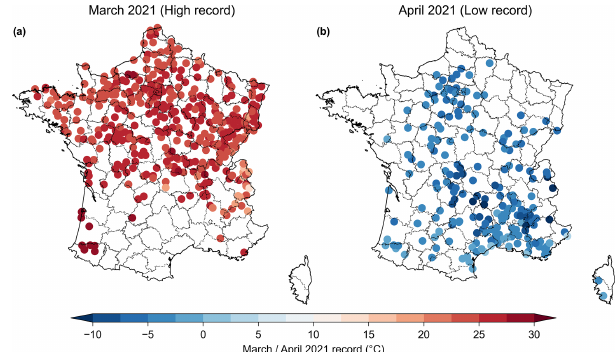
Figure 1. Stations with March (a) high records broken (pink ther- mometer) and April (b) low records broken (since at least 20 years) (blue thermometers) in 2021 in France. Symbols are superimposed with the record value of the